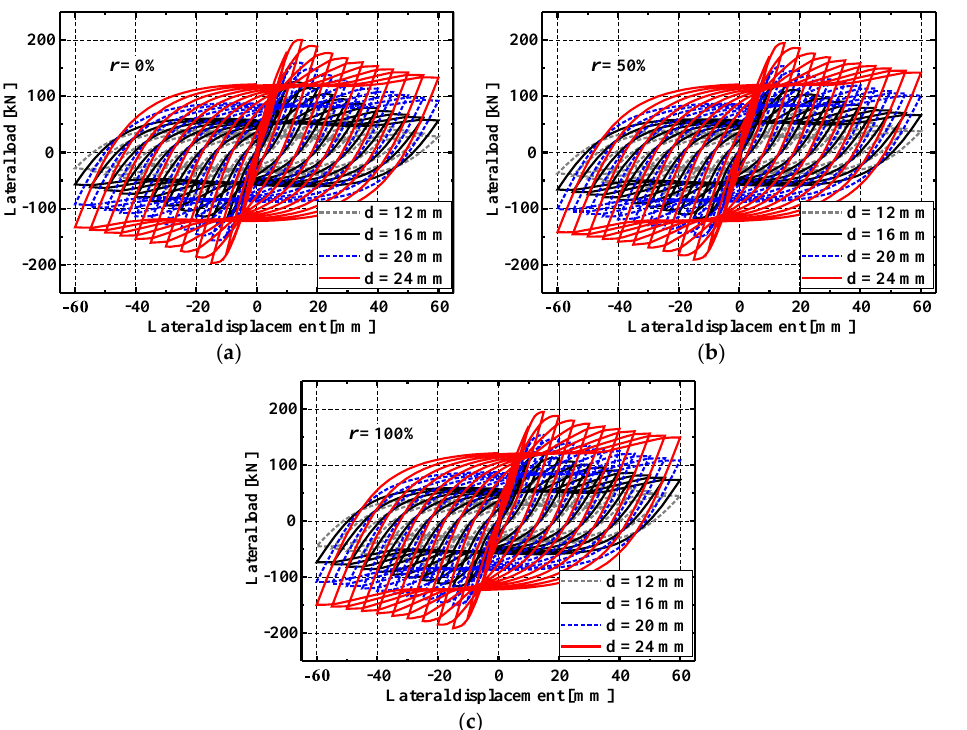
Figure 12. Effect of steel ratio on hysteresis loops of RRC columns ( n = 0.3). ( a ) r = 0%, ( b ) r = 50%, and ( c ) r = 100%.